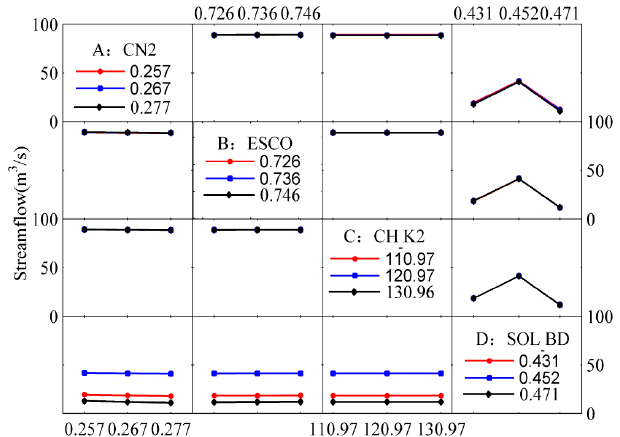
Figure 7. Interaction effects of parameters in the non-flood period.